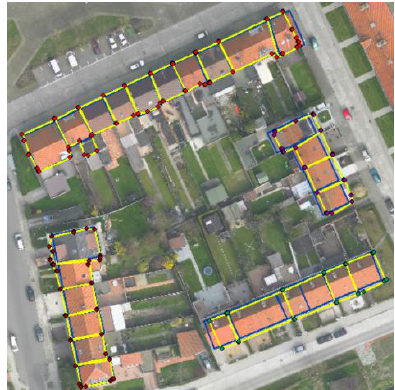
Figure 12 . Digitized footprints in ArcGIS (blue) and extracted footprints by algorithm (yellow) Boundaries of the adjacent buildings in the eastern and western blocks are prone to less error due to closeness to optic